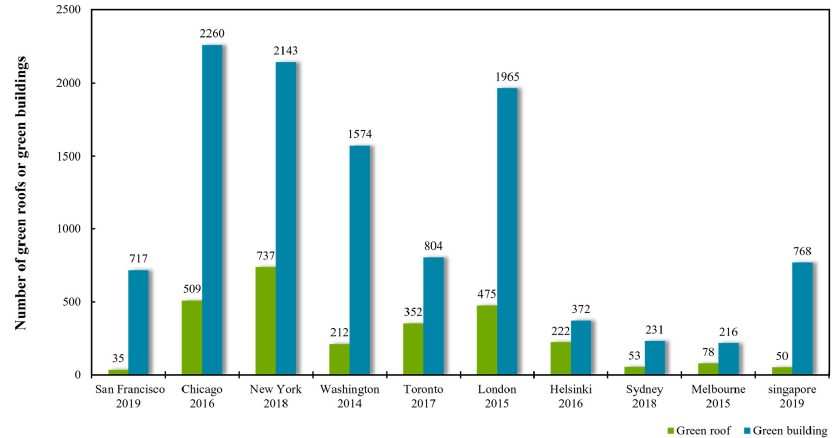
Figure 5. Comparison of the number of green roofs and green buildings in different regions.